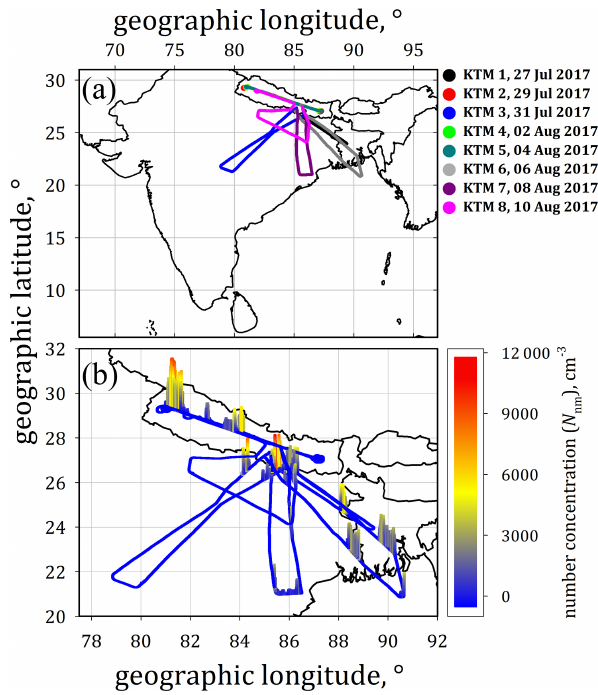
Figure 1. (a) Flight patterns of the StratoClim 2017 mission over Nepal, India, Bangladesh, and the Bay of Bengal. (b) Regions with elevated number concentrations of nucleation-mode parti- cles ( N nm , ambient conditions) of sizes in the diameter range of 6nm <d p < 15nm from COPAS (COndensation PArticle counting System) measurements are indicated by the colour code and by symbol size along the flight